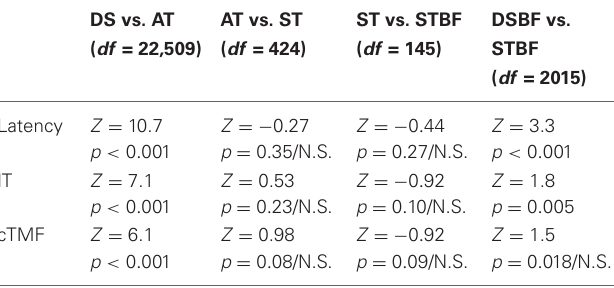
Table 2 | Temporal receptive field similarity between neighboring neurons and their dependence on proximity and frequency